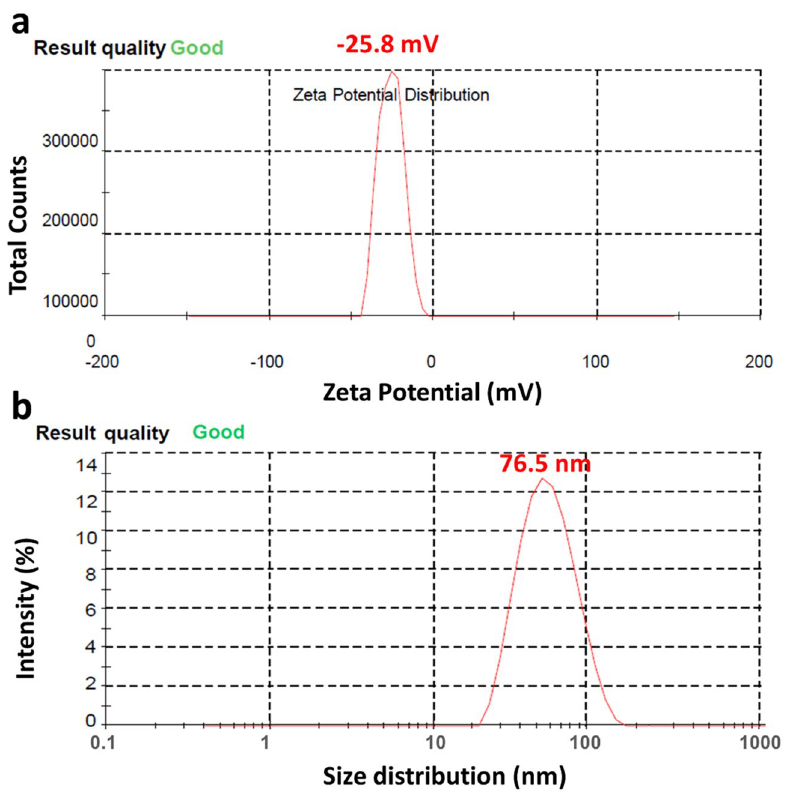
Figure 11. Zeta potential ( a ) and dynamic light scattering ( b ) of the biofabricated Fe 3 O 4 -NPs, depicting the surface charge values and particle size distribution,